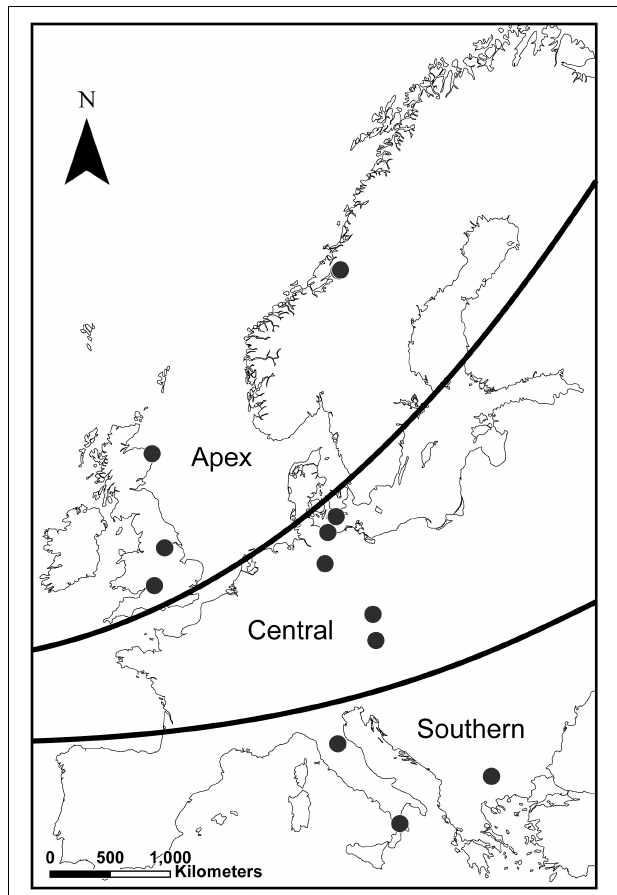
FIGURE 1 | Geographical origin of the bank vole samples ( n = 21). Map shows the geographic origin of the samples in the three latitudinal zones: southern refugial ( n = 6), which includes the areas of glacial refugia in the Mediterranean region, northern apex ( n = 7), which includes Great Britain and Fennoscandia as the apex areas of the northward end-glacial colonization; and central ( n = 8), which has a mixed history of glacial survival and post-glacial colonization. Geographically proximate sampling sites may overlap (see Supplementary Table S2 for